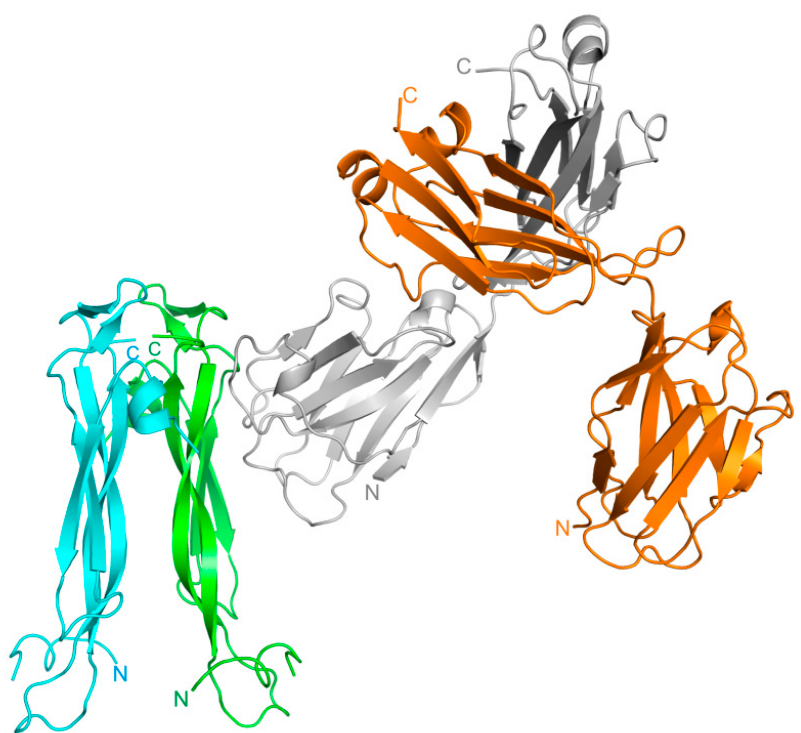
Figure 3. Superposition of the netakimab Fab fragment structure (PDB code 6QKD) on the structure of the V H H domain in complex with IL-17A (PDB code 8B7W). The heavy chain is shown in grey, the light chain is in orange. IL-17A monomers are shown in blue and green. Table 2. Kinetic analysis of interactions of IL-17A with netakimab antibody and its fragments—the Fab fragment and the V H H domain